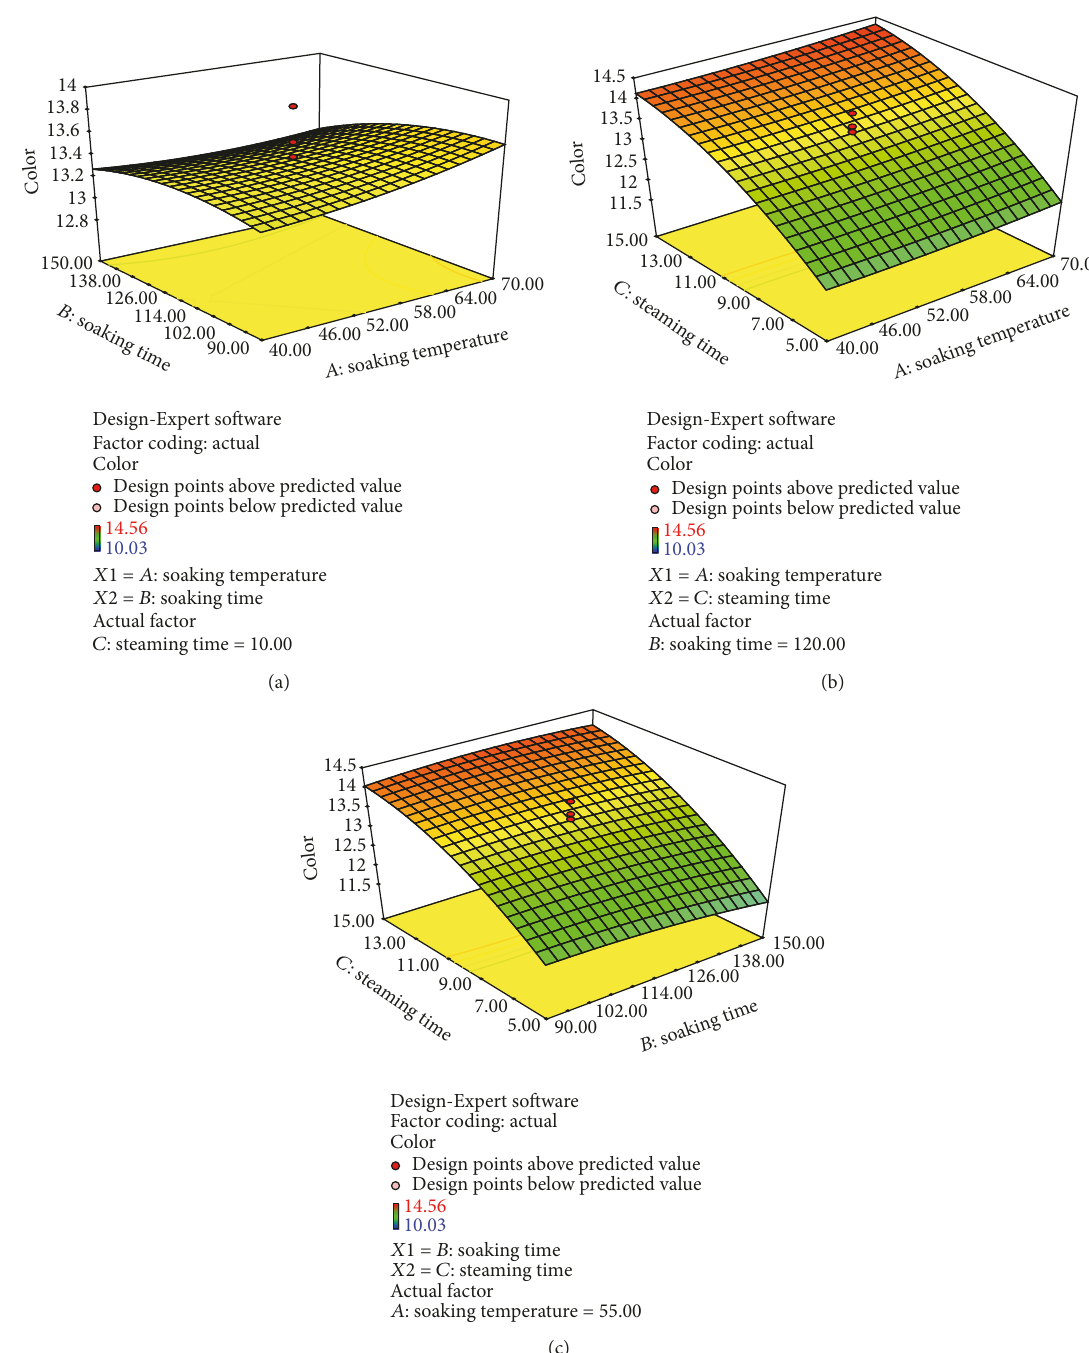
Figure 6: Effect of soaking temperature, soaking time, and steaming time on color ( 𝑏